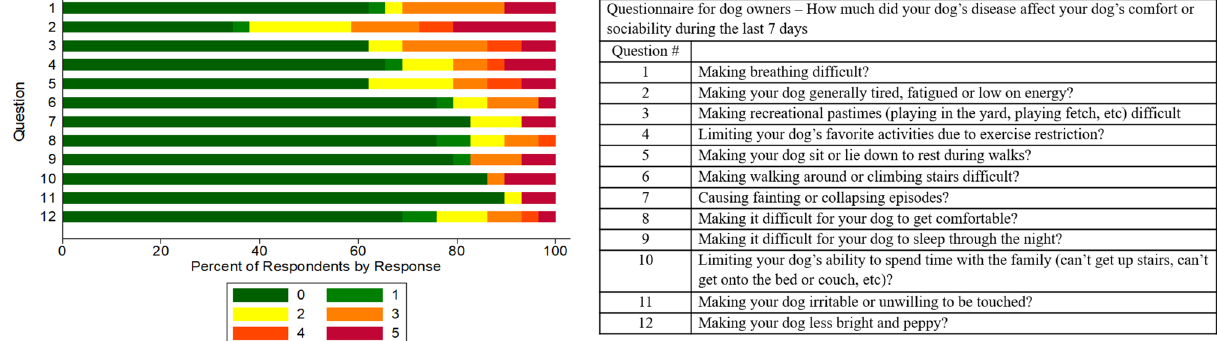
Figure 2. Distribution of the owner responses for each of 12 quality of life (QOL) questions for dogs with hereditary methemoglobinemia. A modified functional evaluation of cardiac health (FETCH)-questionnaire was used with questions that were not pertinent to methemoglobinemia omitted 33 . Color shows percent of response for each response option from 0 (not at all) to 5 (very much) for each